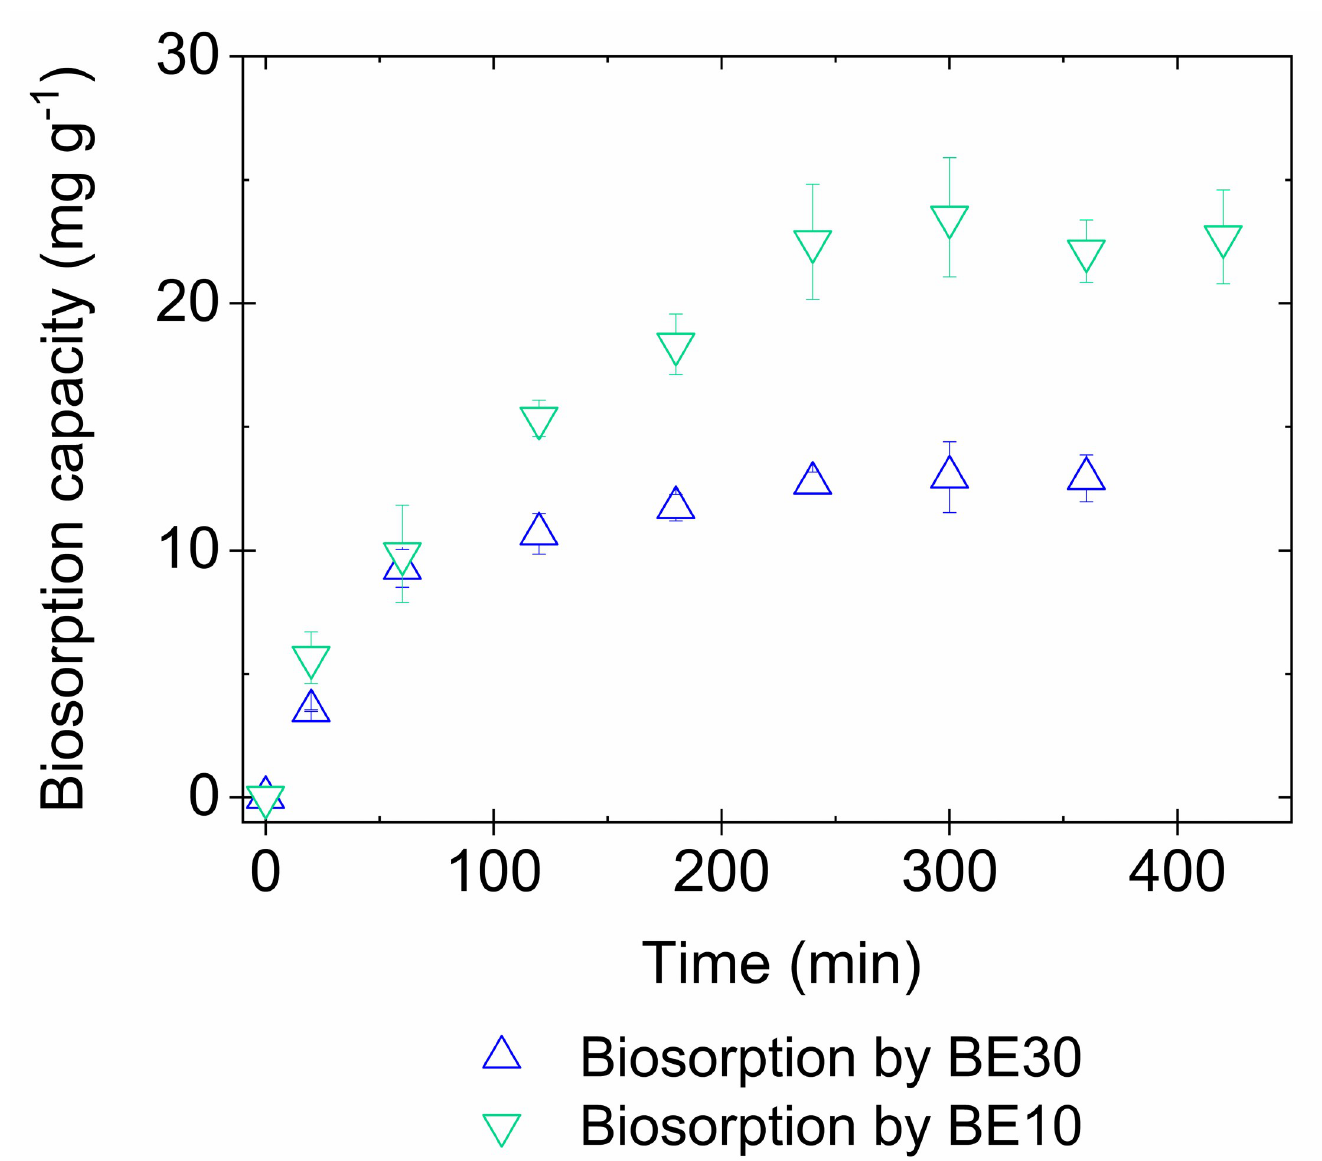
Fig 2. Kinetic of copper biosorption by EB30 and EB10. Conditions: Initial copper concentration = 100 mg L -1 ; pH i = 5 ± 0.1; agitation speed = 150 rpm; temperature = 25 ± 2˚C; biosorbent dosage for EB10 = 0.333 g L -1 and for EB30 = 1.0 g L -1 .